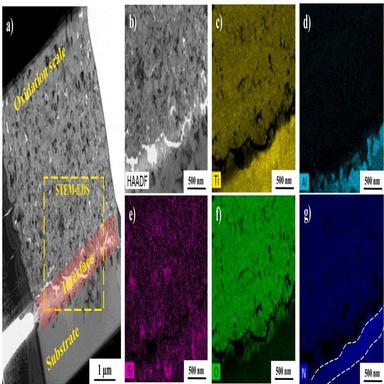
Microstructure and element distribution of the TEM sample from the (TiC+TiB+(TiZr)5Si3)/TA15 composites after oxidation at 800 ◦C for 100 h: (a) TEM-BF image of the sample, (b) the HAADF image of the corresponding area in (a), (c–g) STEM-EDS elemental mappings of Ti, Al, Si, O, N across the (b).